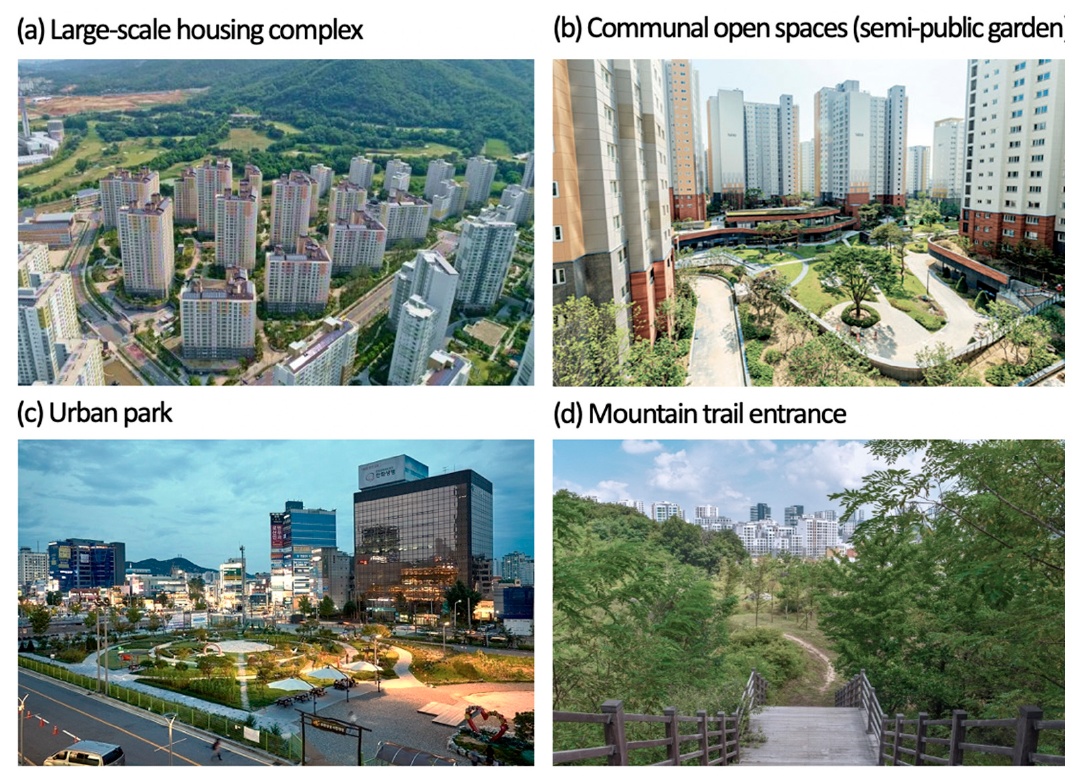
Figure 3. Aerial views of housing complexes and internal/external green amenities in Gyeonggi Province—Large-scale housing complexes, semi-public garden of communal open spaces, urban parks and mountain trail entrance, in order (Source: [53,54,55,56]).